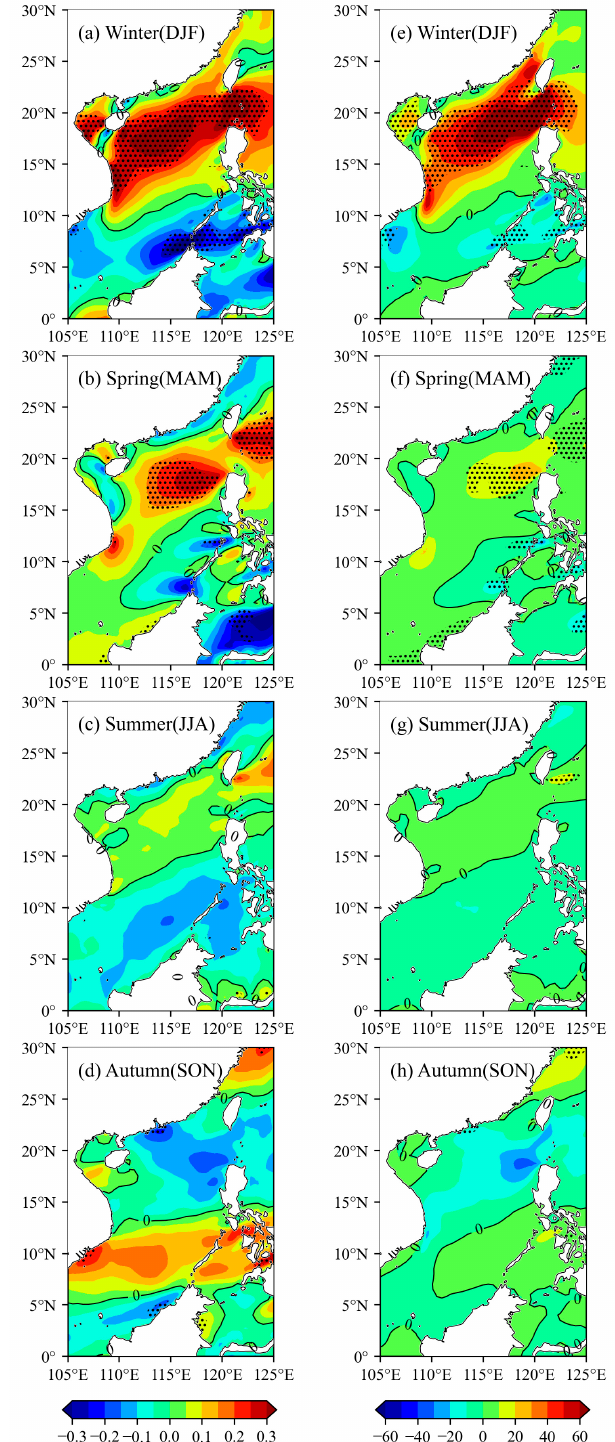
Figure 6. The linear variation trends of the seasonal mean wind (( a – d ), unit: m · s − 1 · (10a) − 1 ) and the wind power density (( b – h ), unit: W · m − 2 · (10a) − 1 ) over the SCS from 1979 to 2021. The black dots indicate the significant areas with more than a 95% confidence level (which was achieved through using Student’s t -test). Moreover, ( a , e ): winter; ( b , f ): spring; ( c , g ): summer; and ( d , h ):